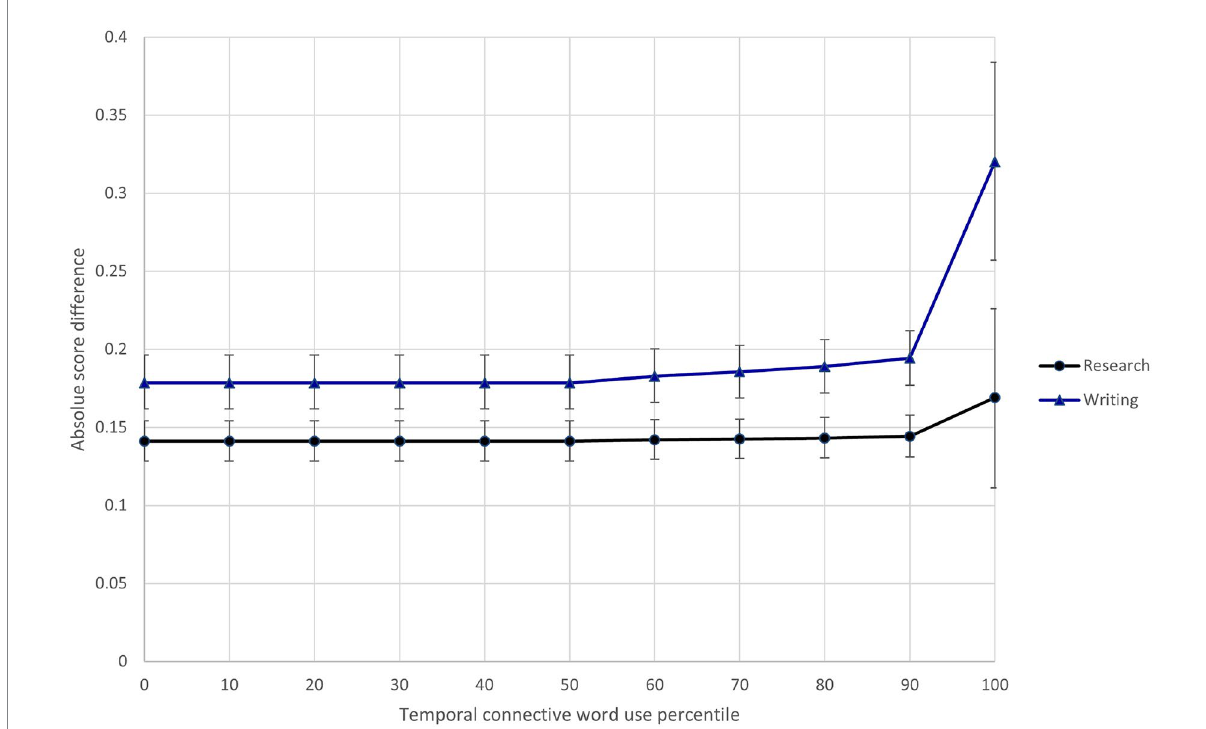
FIGURE 6 Differential influence of response temporal connective word use on difficulty of scoring research and writing